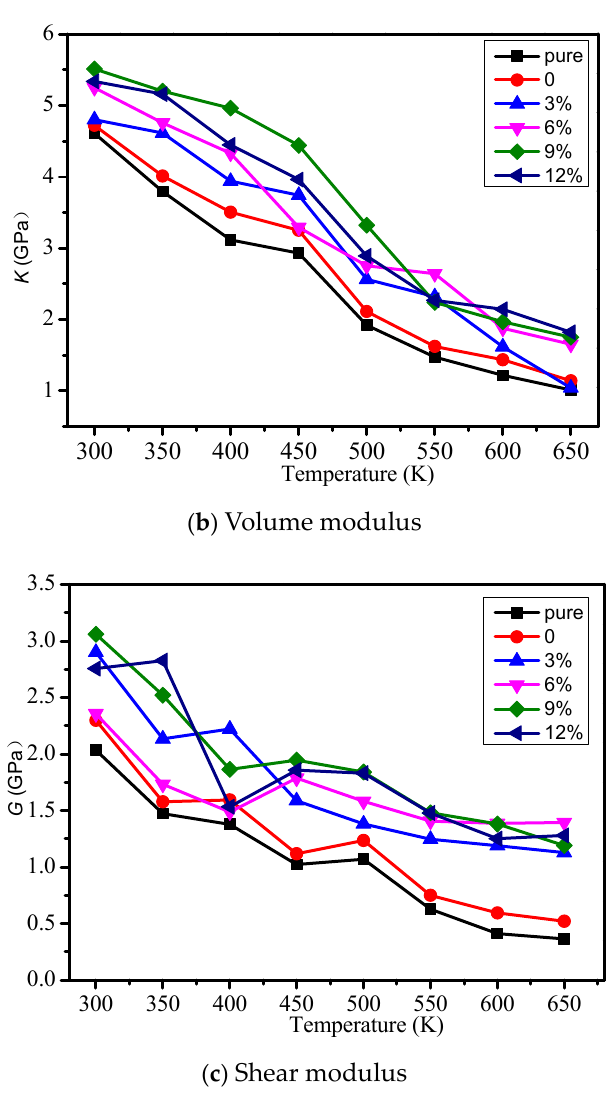
Figure 3. Mechanical property of different models. ( a ) Young modulus; ( b ) Volume modulus; ( c ) Shear modulus.